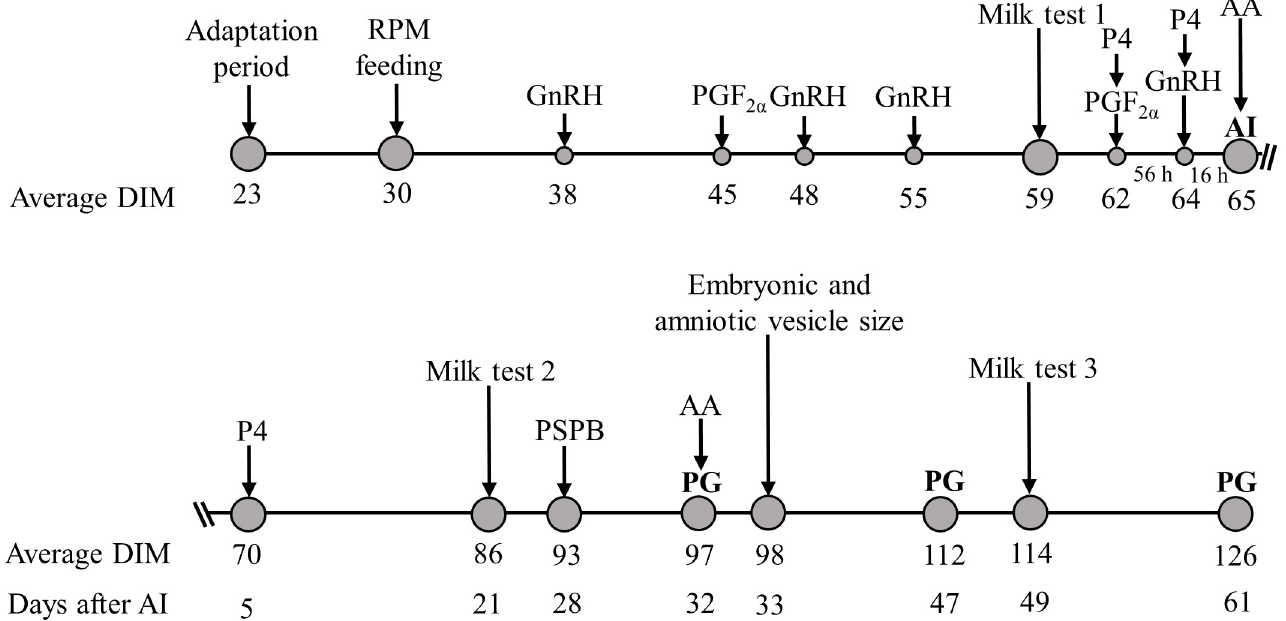
Fig 1. Schematic representation of experimental protocol showing the period of adaptation (7 days), 96 days of feeding (CON vs. RPM), the reproductive protocol used, and each measurement taken throughout the experiment. The DoubleOvsynch protocol was used to synchronizeovulationin all cows and timed AI was performed on Day 65 ± 3. Pregnancydiagnosis (PG) were performed on Days 32, 47, and 61 after AI. RPM feedingstarted on Day 30 ± 3 and continueduntil a cow was diagnosednot pregnanton Day 32 or until Day 61 after AI. Blood samples were collected on Day of last PGF 2 α and GnRH and on Day 5 and 28 after AI to analyzeprogesterone (P4) concentrations, on the week of AI and first PG to analyze AA concentrations, and on Day 28 after AI to analyzePregnancy specific-protein B (PSPB) concentrations. Ultrasoundvideos were made on Day 33 after AI to evaluateembryonicand amniotic vesicle size. Milk tests were performed at (58 ± 9; mean ± SD), 73 to 100 (87 ± 9), and 101 to 128 (115 ± 9) DIM.